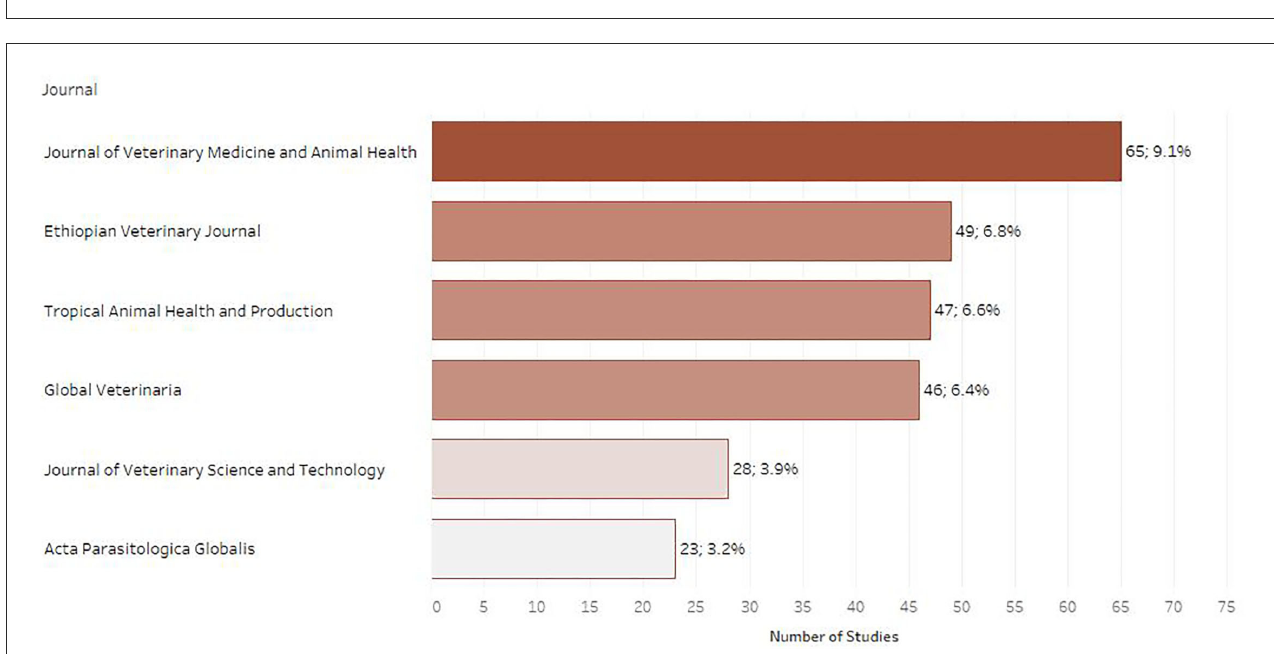
FIGURE3 Number of retrieved studies published in each scientific journal (only journals with 20 or more retrieved studies are displayed).